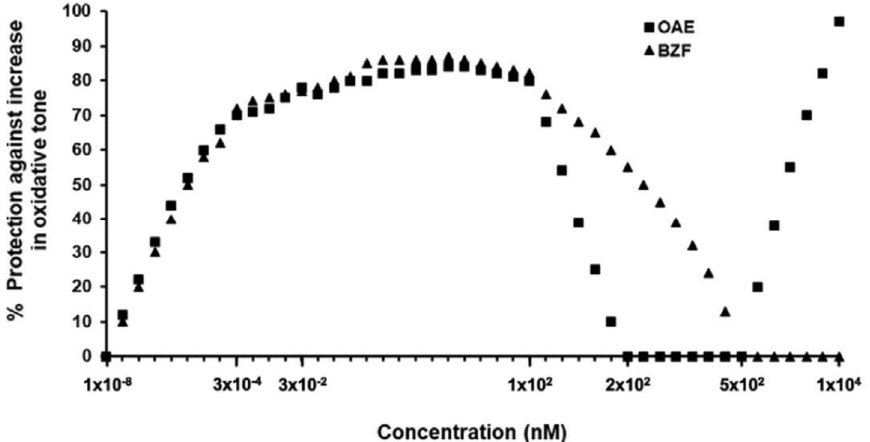
Figure 4. Antioxidant effects of increasing concentrations of Q-BZF present in either a pure Q-BZF preparation ( ▲ ) or an onion aqueous extract (OAE) ( ■ ) (Reproduced with permission from [229], preparation ( (cid:78) ) or an onion aqueous extract (OAE) ( (cid:4) ) (Reproduced with permission from [229], copyright 2020 Elsevier). copyright 2020